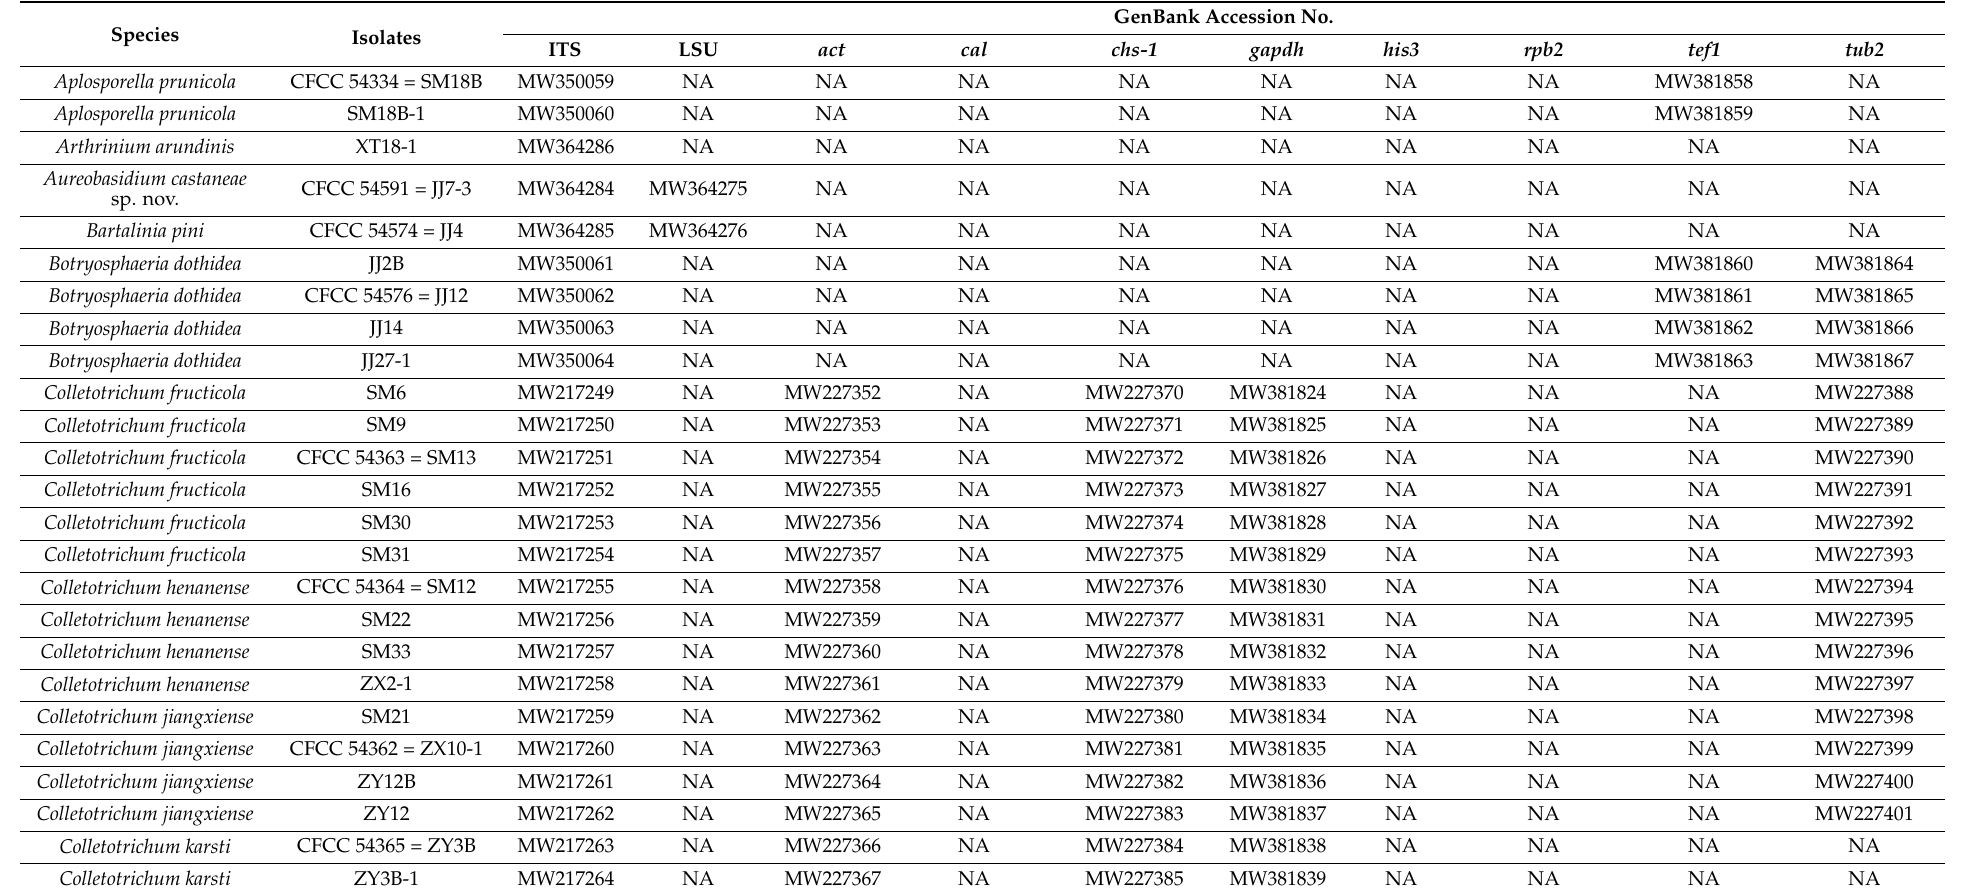
Table 2. Isolates and GenBank accession numbers of sequences from this